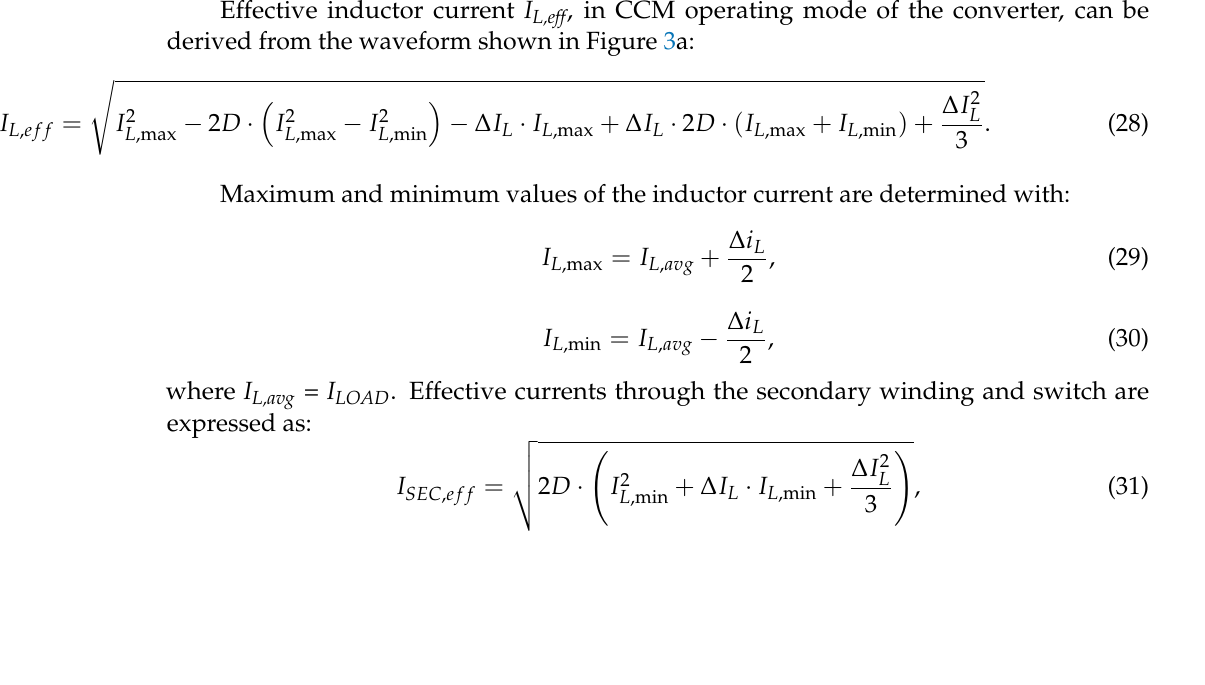
Figure 3. Characteristic voltage and current waveforms for push–pull converter: ( a ) CCM operation mode, ( b ) DCM operating mode.